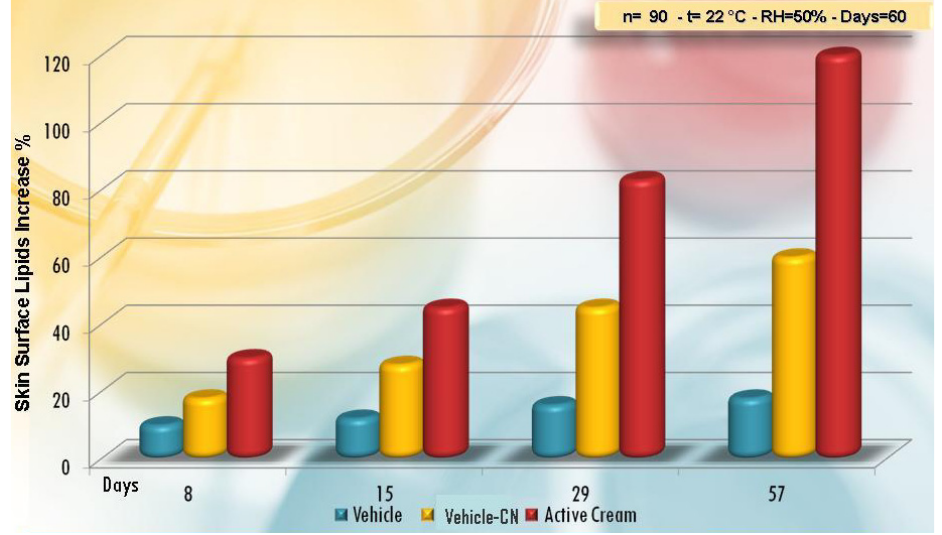
Figure 9. Activity of chitin nanofibrils alone or complexed with antioxidant and immunomodulant ingredients (active cream) as a vehicle on superficial skin lipids of the skin of photo-aged women. All p values are highly significant as control and as each other groups ( p < 0.005).